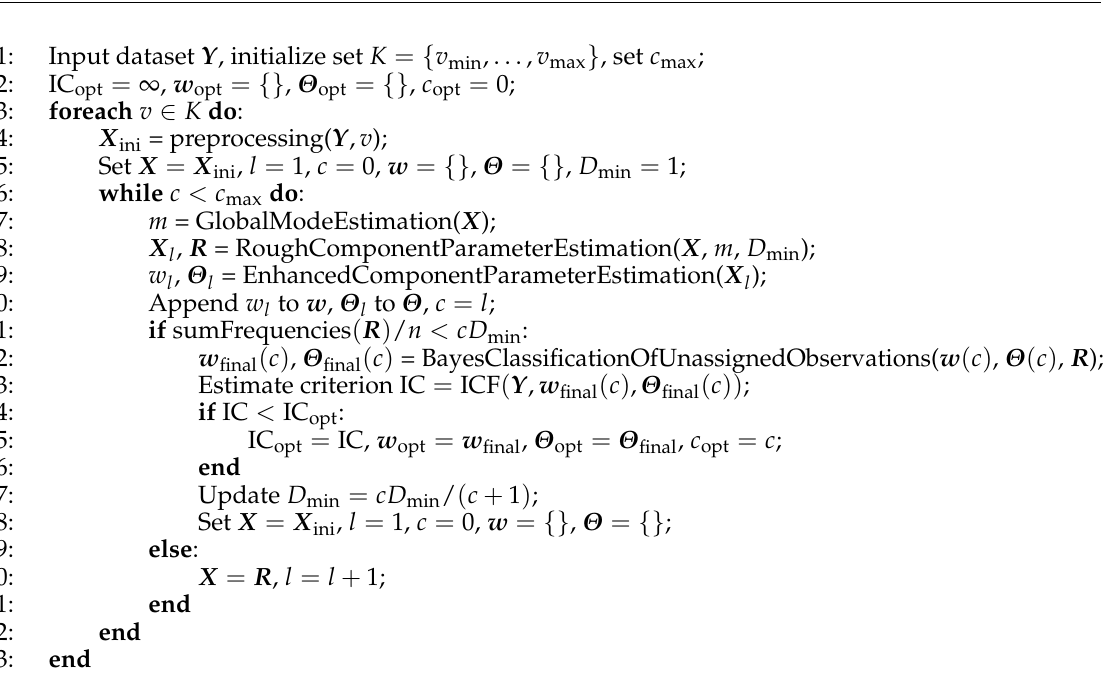
Algorithm 4: Rough-enhanced-Bayes-mixture estimation algorithm